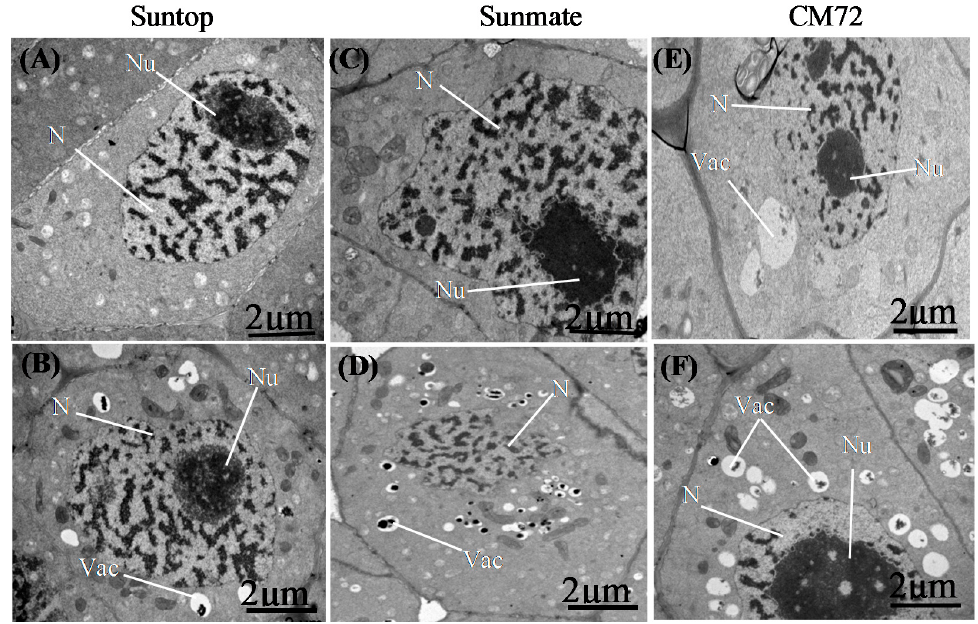
Figure 7. Electron micrographs of roots of Suntop ( A , B ), Sunmate ( C , D ), and CM72 ( E , F ) under control (top panel) and 100 mM NaCl (bottom panel). CW, cell wall; Nu, nucleolus; N, nucleus; Vac, vacuole.